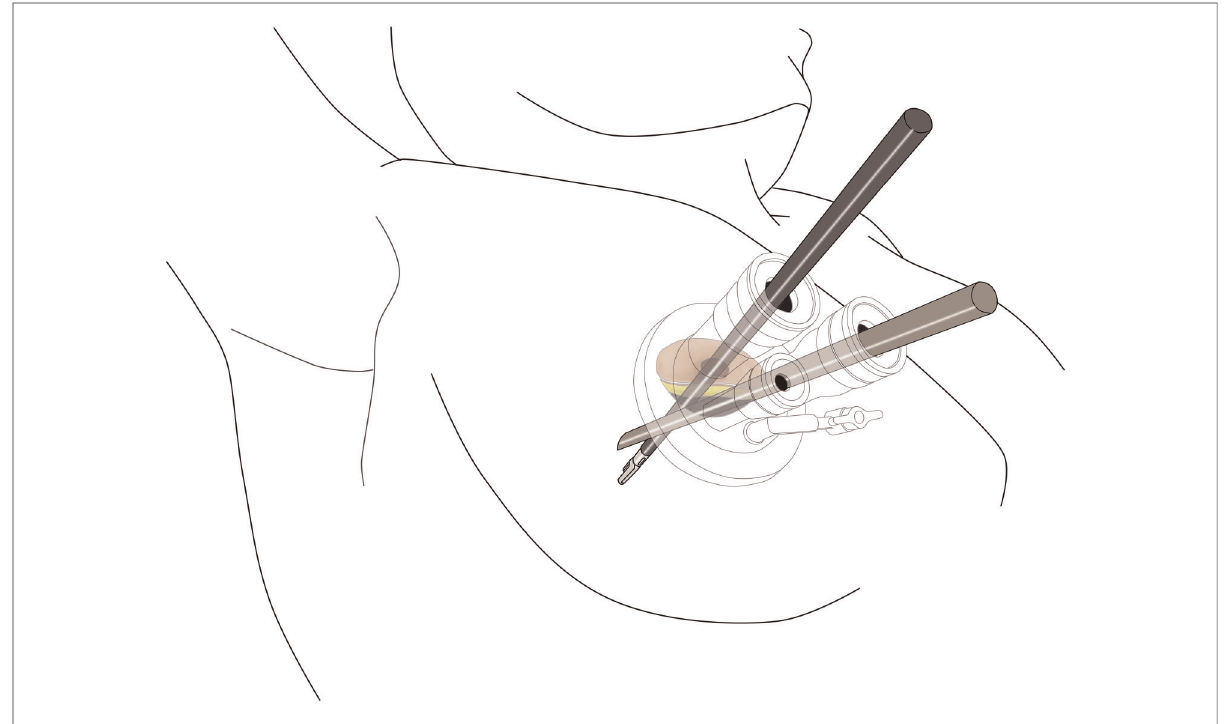
FIGURE 2 Procedure of TUTET for patients with